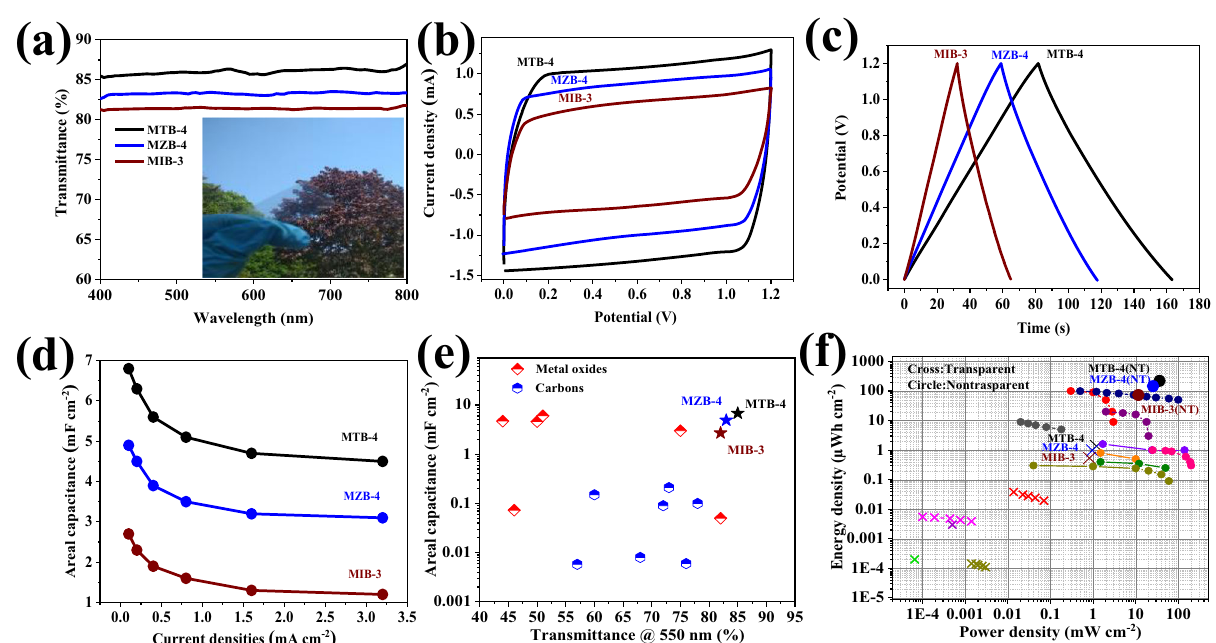
Fig. 4 Optical and electrochemical evaluation of TFSCs. a Transmittance spectra of TFSCs based on MTB-4, MZB-4, and MIB-3 electrodes. Inset: photograph of TFSCs based on MTB-4 electrode. b Cyclic voltammetry (CV test at 0.05 V s − 1 ) for MTB-4, MZB-4, and MIB-3 based TFSCs. c Galvanostatic charge/discharge (CC test at 0.1 mA cm − 2 ) for MTB-4, MZB-4, and MIB-3 based TFSCs. d Areal capacitance of MTB-4, MZB-4, and MIB- 3 based TFSCs at different current densities. e Comparing the areal capacitance and transparency (at 550nm) of our TFSCs with recent carbon 7,65,77 – 81 or metal oxide 82 – 87 based transparent supercapacitors. f Ragone plots of MTB-4, MZB-4, and MIB-3 based TFSCs and non-transparent devices (MTB-4(NT), MZB-4(NT), and MIB-3(NT)) compared with previously reported values in state-of-the-art transparent (cross symbol) 7,65,77 – 79 and non-transparent (circle symbol) 42,88 – 94 planar